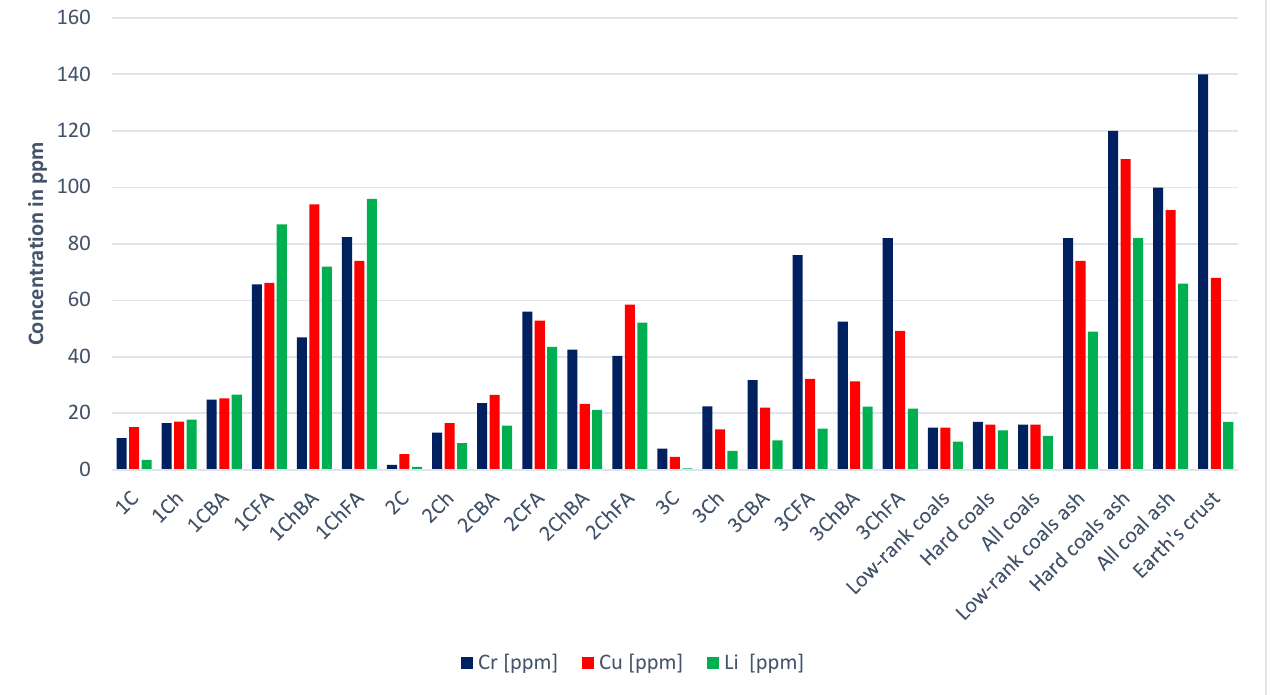
Figure 6. The Cr, Cu, and Li content of coal, char, ashes and their Clarke values [21].